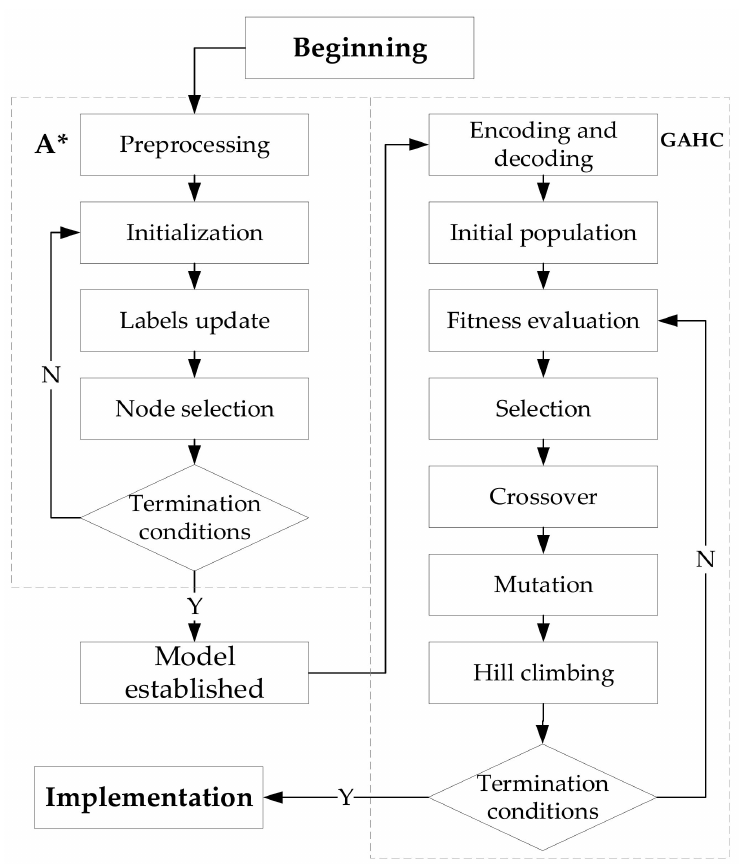
Figure 8. The flowchart of the indoor route